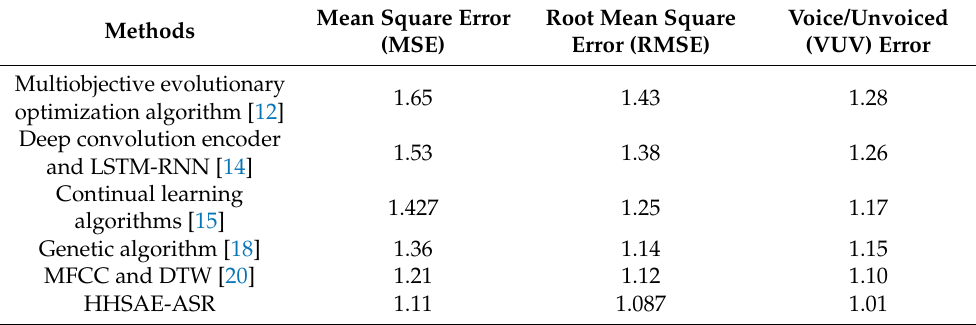
Table 1. Training values Error rate in Speech Processing.